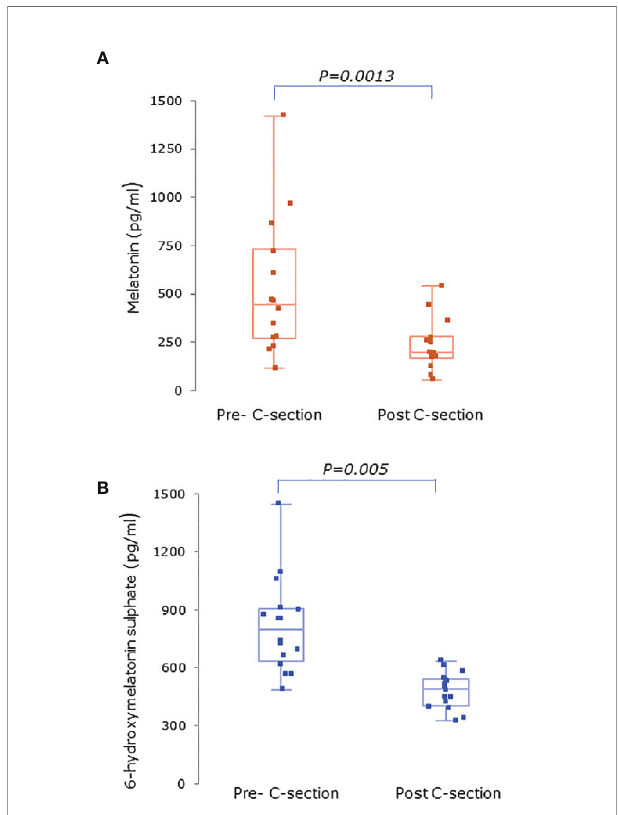
FIGURE 5 | (A) Serum melatonin and (B) serum 6-hydroxymelatonin sulfate levels in pregnant women (n = 15) 3 – 6 days before and 24 h after elective C-section (MEL-P2). Levels were signi fi cantly after C-section (P = 0.0013 and P = 0.005 respectively, Wilcoxon-Mann Whitney test). Data are shown as median, interquartile, and full